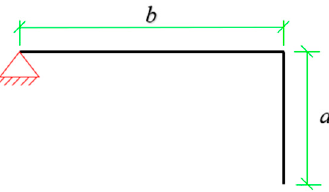
Figure 2. Analytical model for the simple edge stiffener.